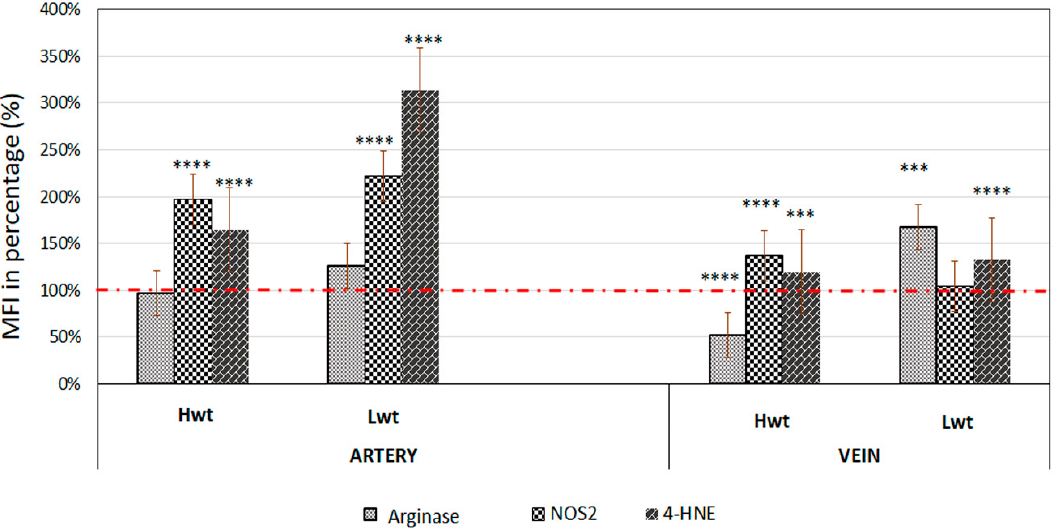
Figure 2. Quantification of the expression level of Arginase1, inducible NOS (NOS2) and the extent of macromolecular damages as followed with the lipid peroxidation marker 4-HNE. Mean fluorescent intensity (MFI) was expressed in percentage of the mature twin neonates (Hwt and Lwt) with their age and weight matched singletons (Hws and Lws) taken as controls. The intensity level of the controls was considered as 100% (marked with red dotted line). The significant differences were accepted at *** p < 0.001 and **** p < 0.0001 based on one-way ANOVA using the Newman-Keuls multiple comparison test.